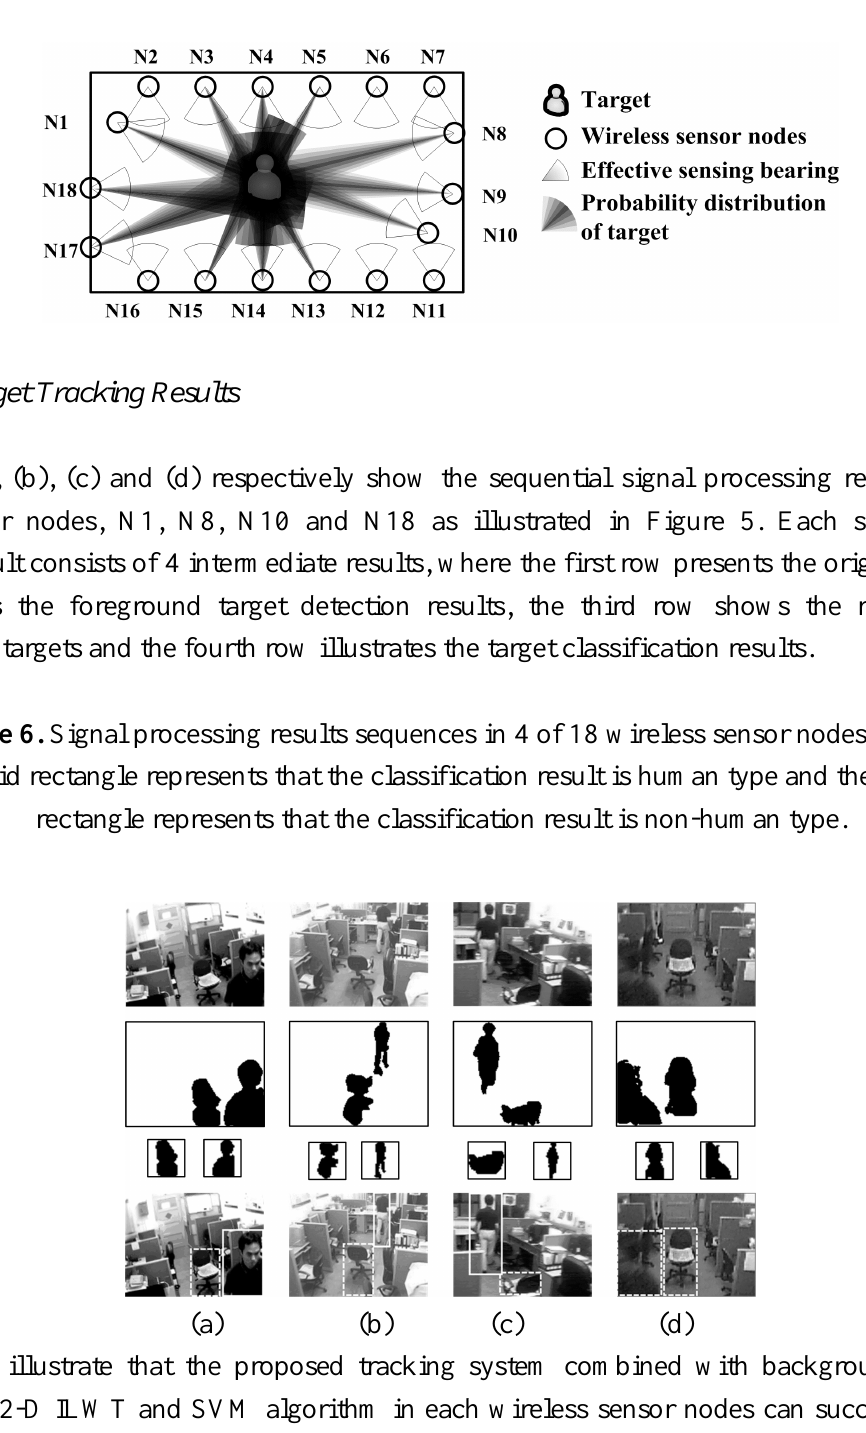
Figure 5. The setup scenario of the wireless sensor network in distributed P2P framework.